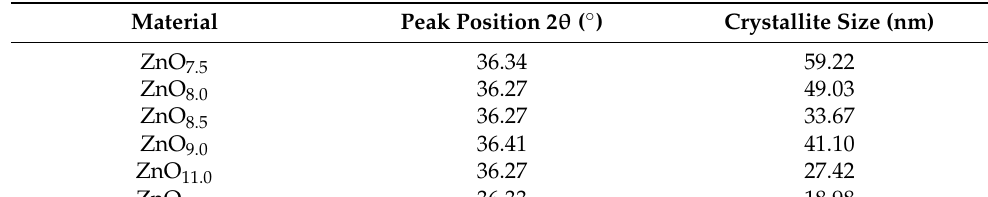
Table 4. ZnO x crystallites sizes estimated via Scherrer’s equation. Subscript x corresponds to the pH adjusted before the hydrothermal synthesis.